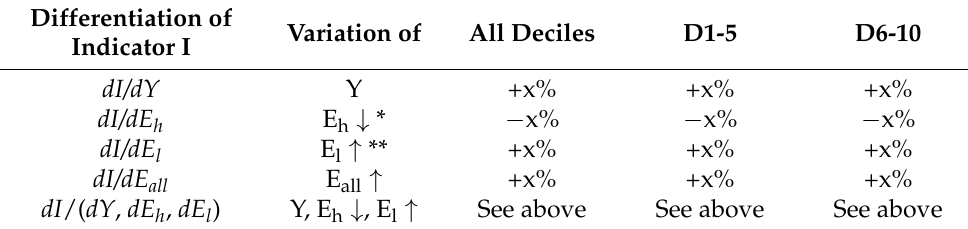
Table 2. Sensitivity tests of indicator I, with I = [HS, LA] and x = 5%, 10%, 15%, and